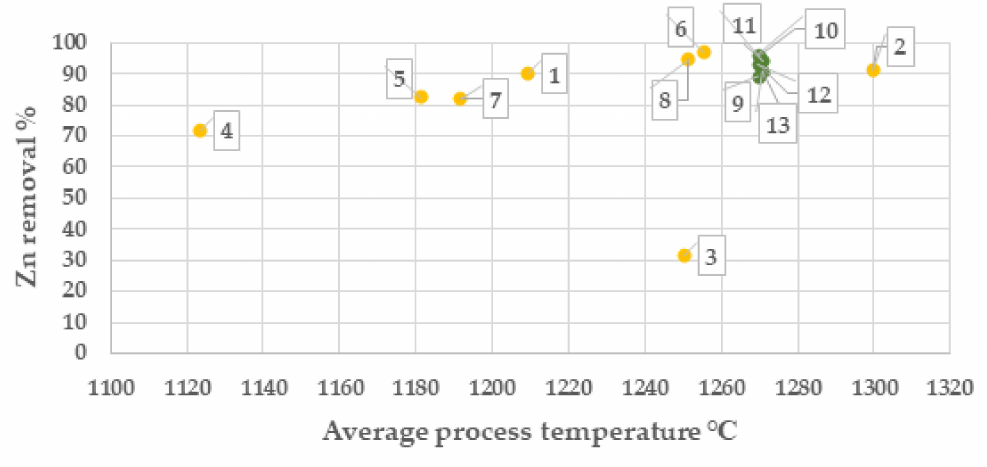
Figure 6. Zinc separation degree (%) at average OXYFINES process temperature (campaign 1, yellow colour and campaign 2 green colour). Points in chart are presented with index number for the respective